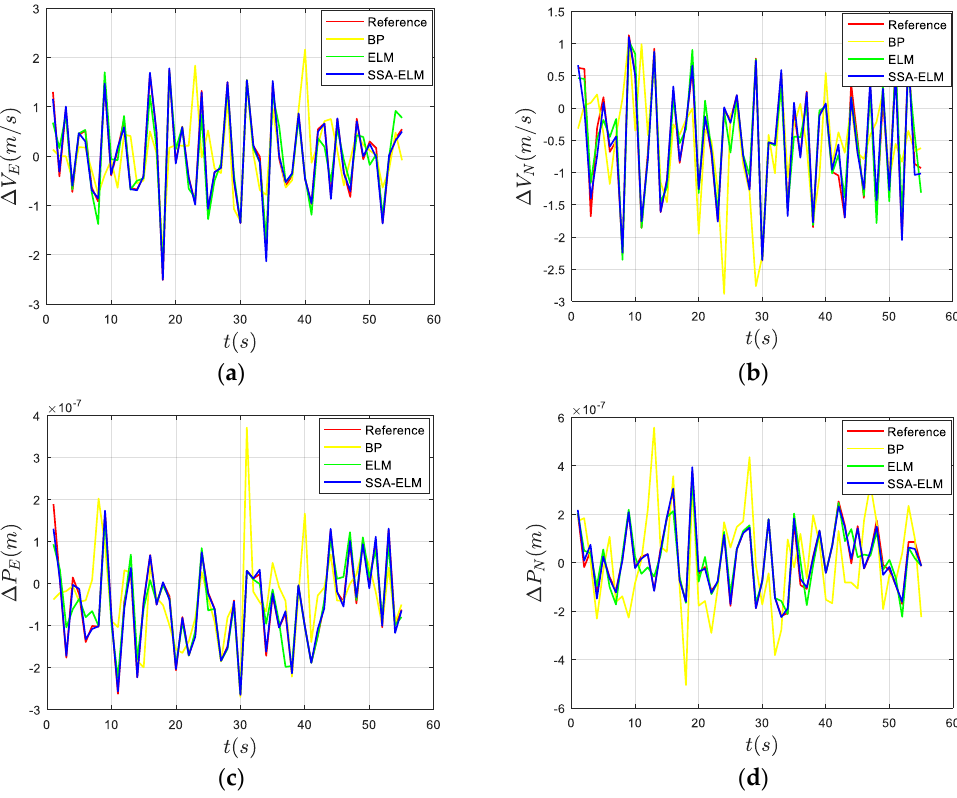
Figure 10. Velocity and position difference prediction of different methods during the second interruption: ( a ) east velocity difference prediction; ( b ) north velocity difference prediction; ( c ) east position difference prediction; ( d ) north position difference prediction. Table 7. RMSE and MAE of the velocity and position differences of different methods during the second interruption. Error